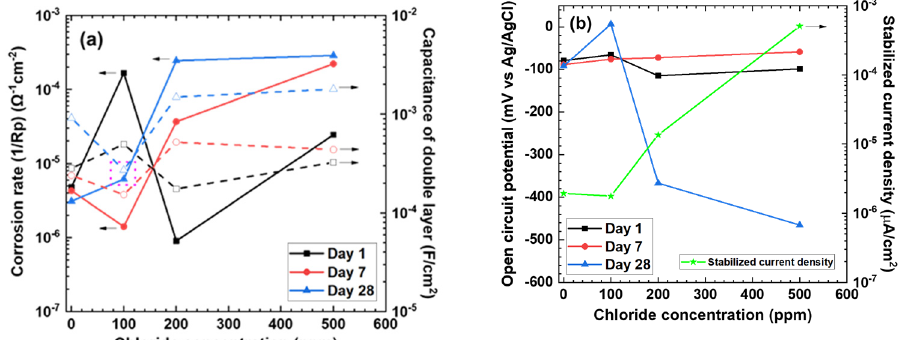
Figure 12. Corrosion rate parameter and double layer capacitance as calculated from EIS tests are shown in ( a ) and potential values obtained from OCP vs. time profile and a stable current density as observed during potentiostatic tests are shown in ( b ); both presented as a function of chloride concentration for cast iron samples with varying exposure times. (Note: Dotted lines in ( a ) are respective double layer capacitances of 0, 100, 200, and 500 ppm chlorides. Also, green line is stabilized current density from Figure 3 of 0, 100, 200, and 500 ppm chlorides.)